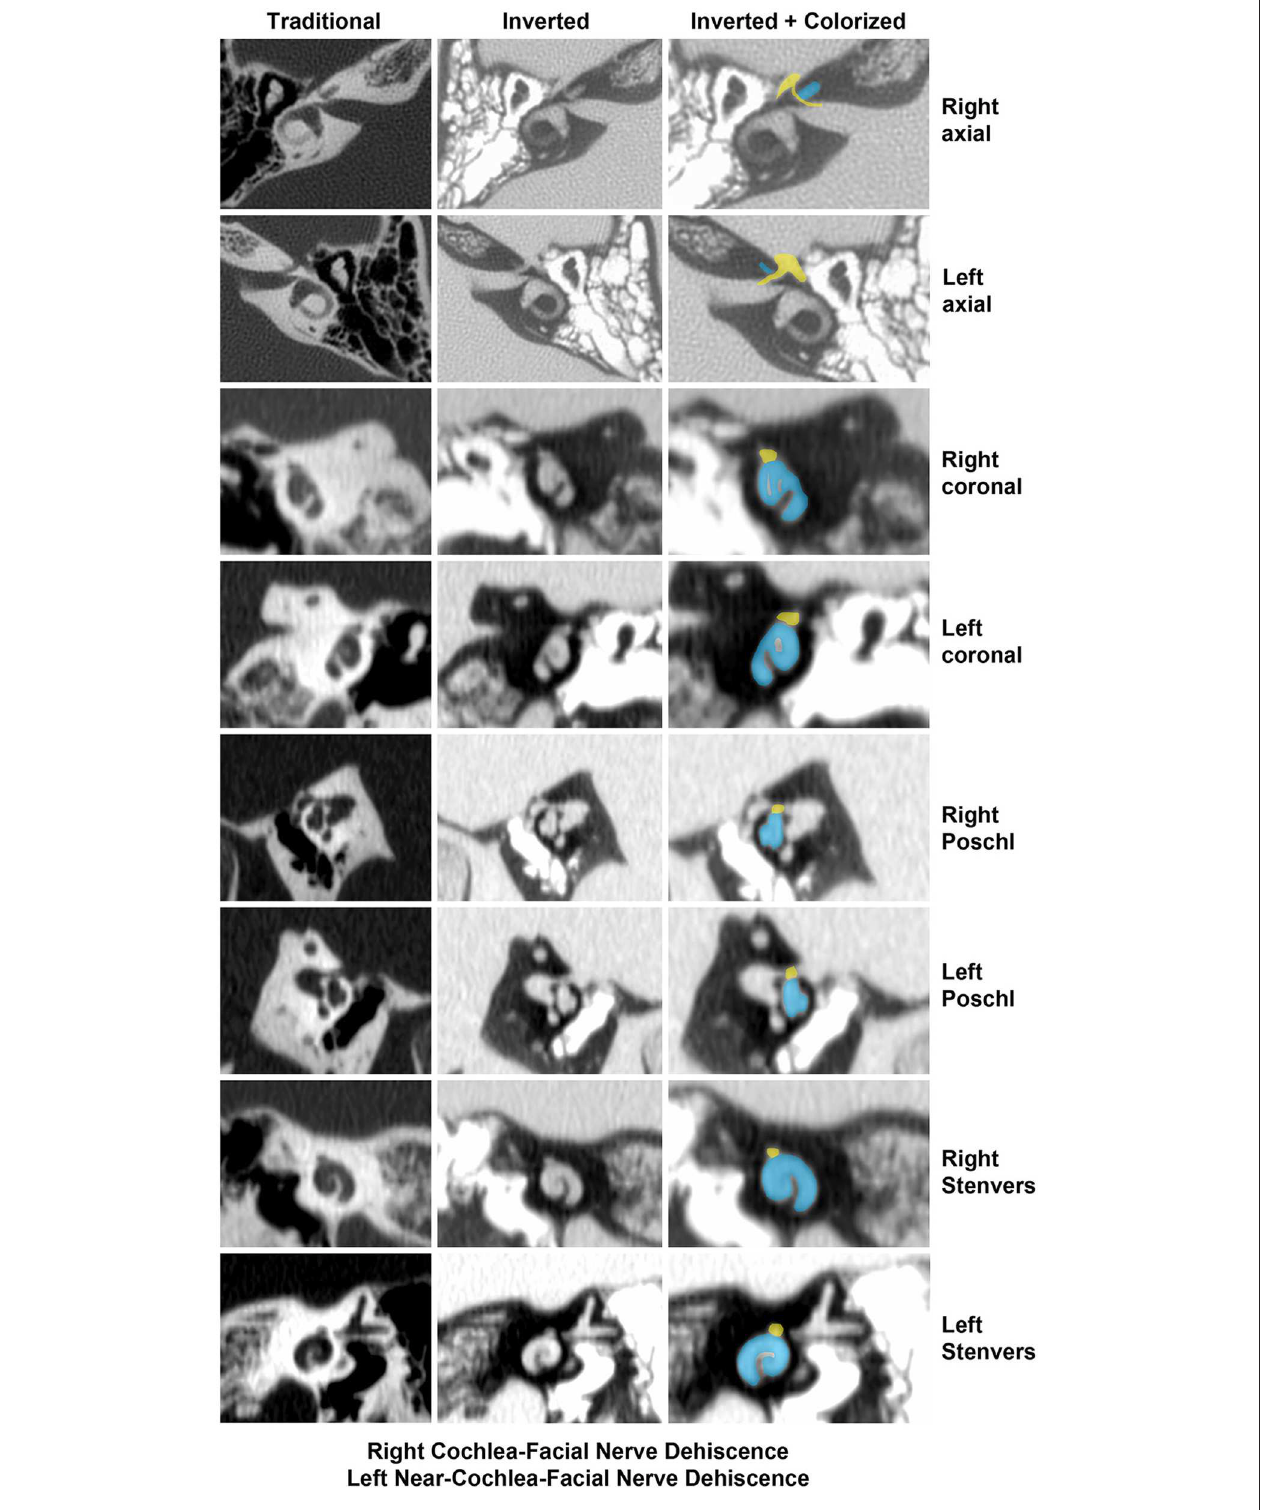
FIGURE 1 | High-resolution temporal bone CT without contrast ( Table 1 , Group 1 Patient 3). Traditional CT images are shown on the far left column. Cochlea (blue) and facial nerve (yellow) have been colorized and superimposed over inverted images in the axial, coronal, Pöschl and Stenvers planes for both the left and right ears. Note that a cochlea-facial nerve dehiscence (CFD) is seen on the left and a near-CFD is seen on the right. The patient has no left-sided third window syndrome symptoms, with resolution of her third window syndrome symptoms after round window reinforcement on the right. Copyright ©P.A. Wackym, used with permission.